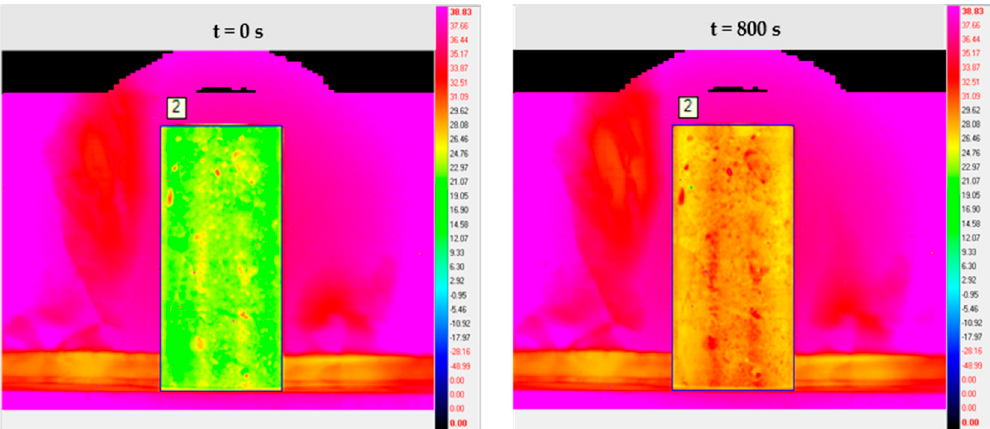
Figure 6. Infrared thermal image of the concrete surface after silane spraying.